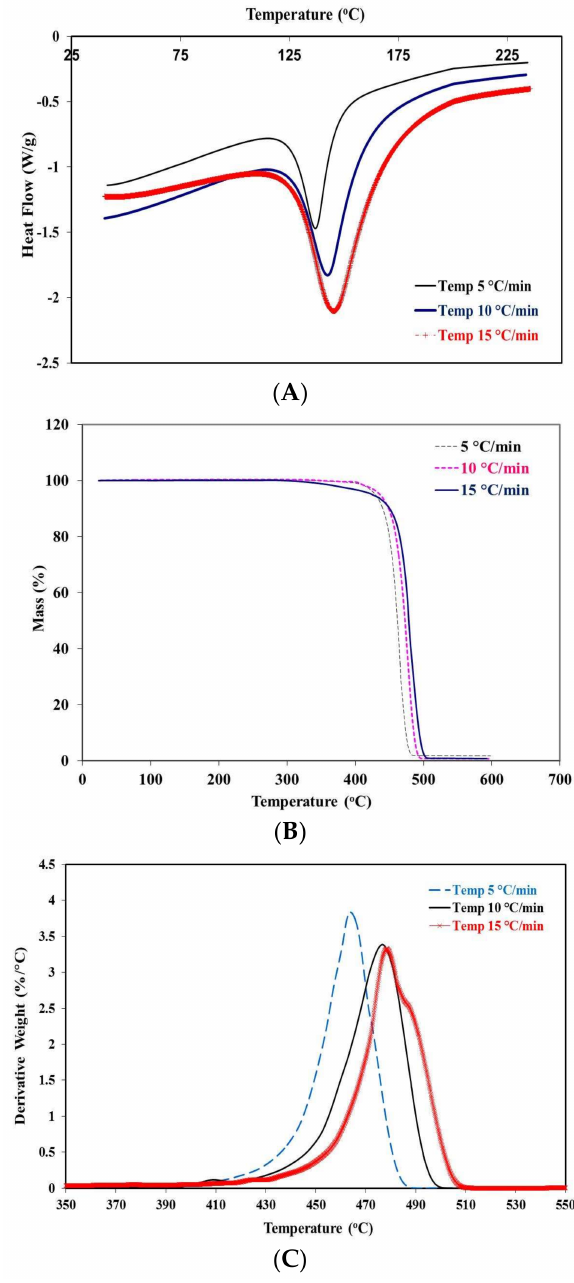
Figure 2. ( A ) Differential scanning calorimetry (DSC); ( B , C ) thermogravimetric analysis (TGA) results for porous polyethylene (PE) at different heating